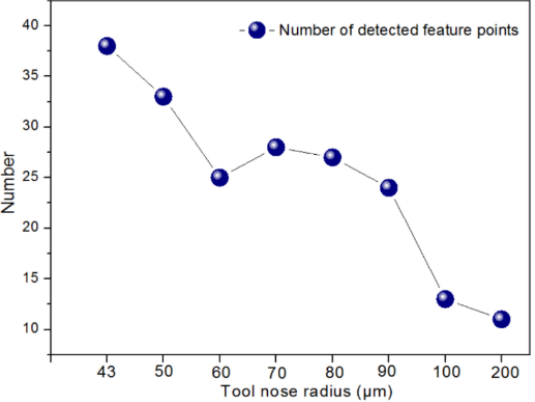
Figure 15. Trend of number of detected feature points (DFP) with different tool nose radii.